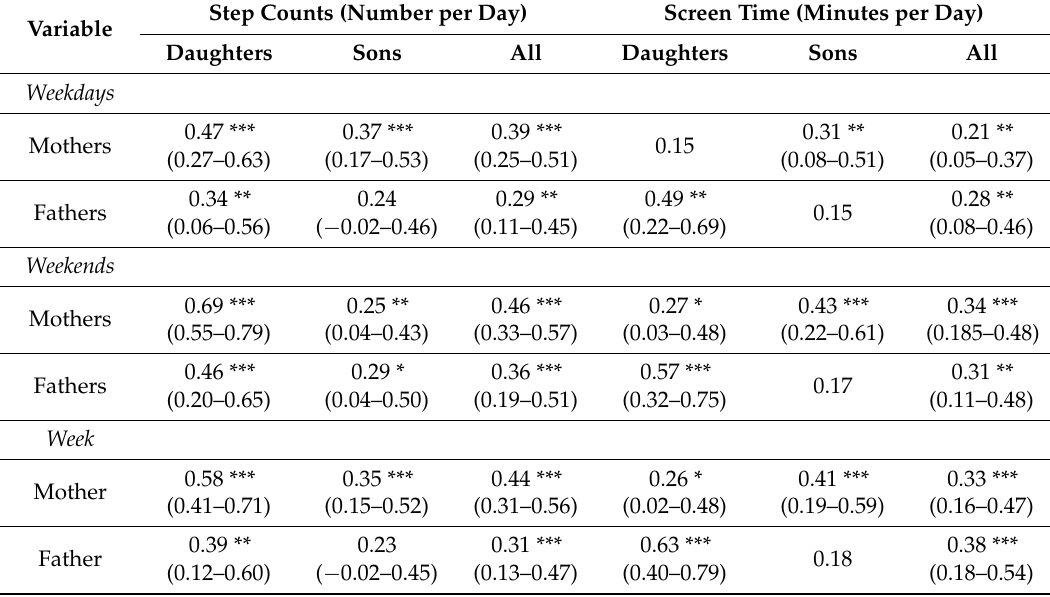
Table 3. Bivariate (Pearson) correlations with 95% confidence intervals (95% CI) between parents’ and children’s daily step counts and screen